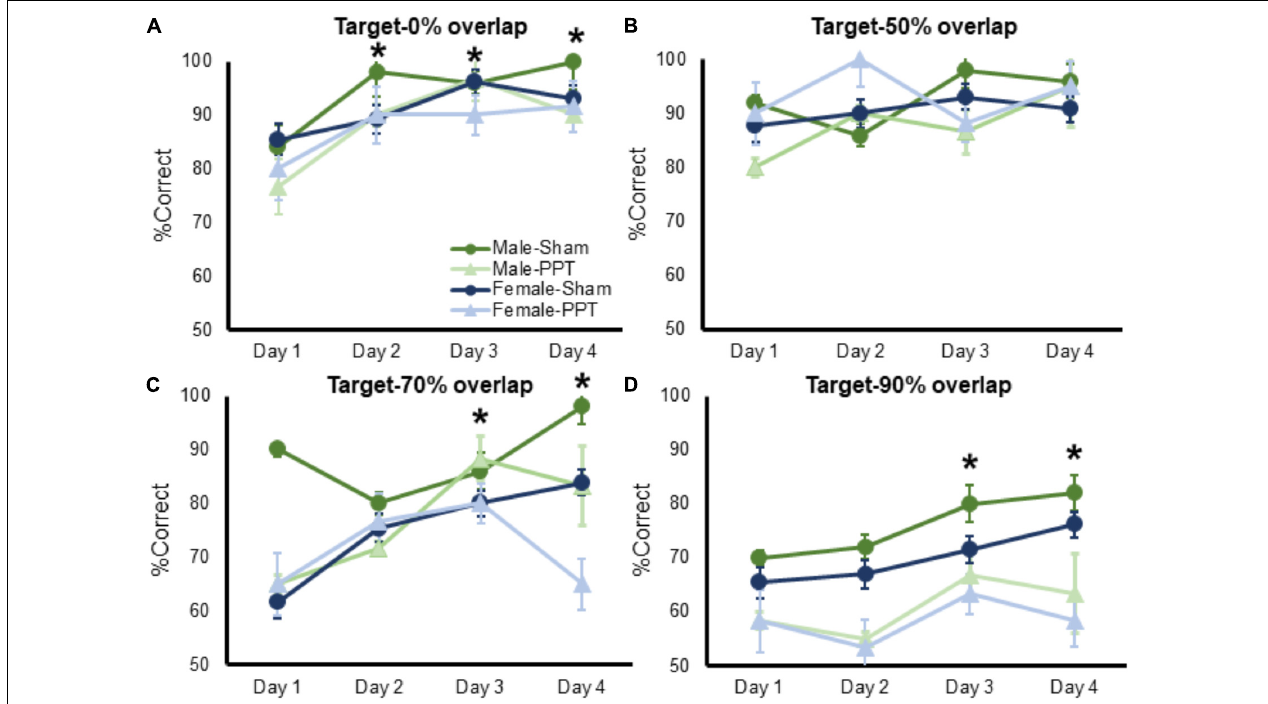
FIGURE 4 | Performance on target-lure discriminations as a function of test day. In all panels mean percent corret is shown on the Y -axis and test day is represented on the X -axis. (A) Performance on 0% lure trials significantly improved as a function of test day ( F [ 1 , 26 ] = 11.73, p = 0.002), which did not interact with sex ( F [ 1 , 26 ] = 0.56, p = 0.65) or experimental group ( F [ 1 , 26 ] = 0.18, p = 0.91). (B) Performance on 50% lure trials did not significantly improve as a function of test day ( Figure 4B ; F [ 1 , 26 ] = 2.16, p = 0.10), and this did not interact with sex ( F [ 1 , 26 ] = 1.35, p = 0.26). The percent of correct trials over testing days did, however, significantly interact with experimental group ( F [ 1 , 26 ] = 3.11, p = 0.031). Post hoc analysis showed that PPT rats improved significantly between test days 1 and 2 (corrected α = 0.05/3 = 0.017; T [ 11 ] = 2.87, p = 0.015), while sham animals did not show a significant improvement across any test day ( p > 0.14 for all comparisons), as they may have already been near ceiling performance at day 1. (C) Performance on 70% lure trials significantly improved as a function of test day ( F [ 1 , 26 ] = 5.52, p = 0.002), which did not interact with sex ( F [ 1 , 26 ] = 2.02, p = 0.12) or experimental group ( F [ 1 , 26 ] = 2.27, p = 0.09). (D) Percent of correct responses on 90% lure trials significantly improved as a function of test day ( F [ 1 , 26 ] = 3.89, p = 0.012), which did not significantly interact with sex ( F [ 1 , 26 ] = 0.14, p = 0.94) or experimental group ( F [ 1 , 26 ] = 0.80, p = 0.50). Error bars are ± 1 SEM. ∗ Indicates significant effect.